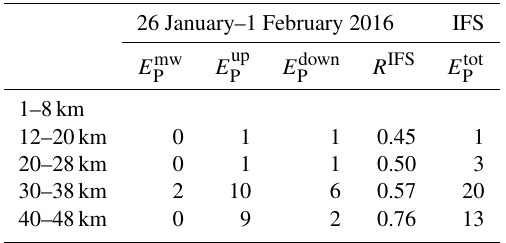
Table 3. IFS results as in Tables 1 and 2 for the period from 26 Jan- uary until 1 February